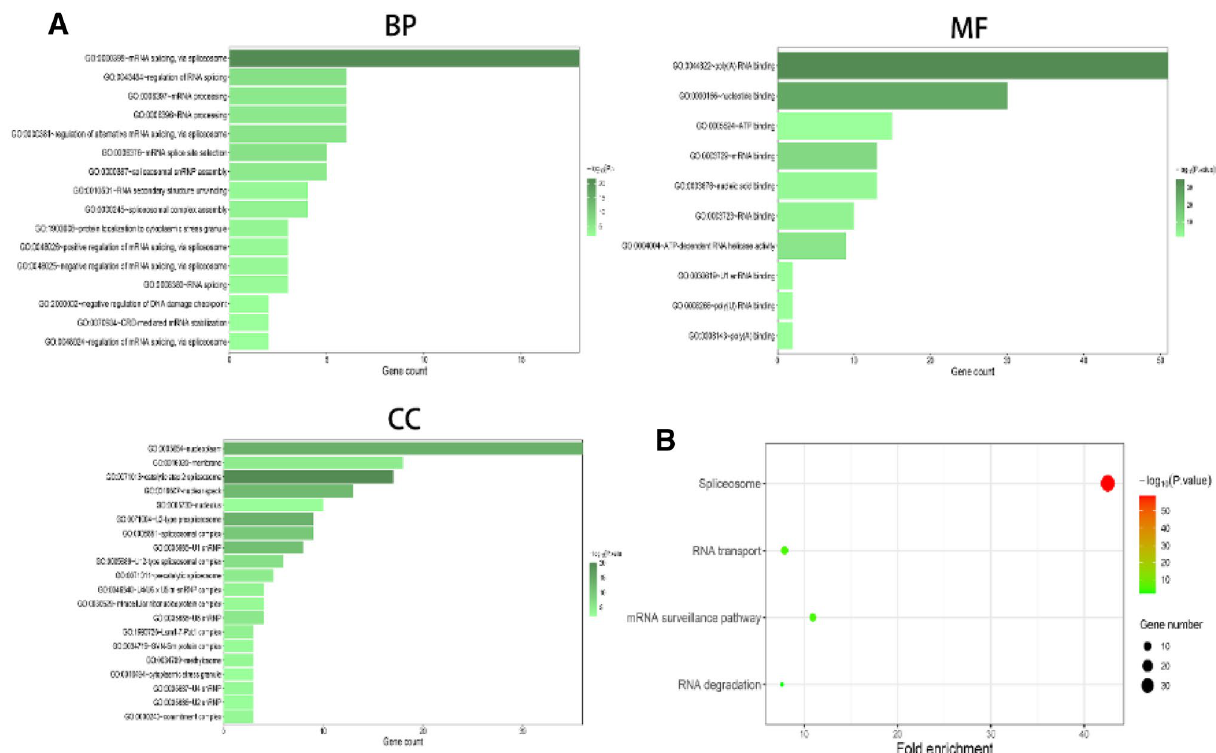
Figure 9. GO functional enrichment analysis ( A ) and KEGG pathway analysis ( B ) of AS event-related SF